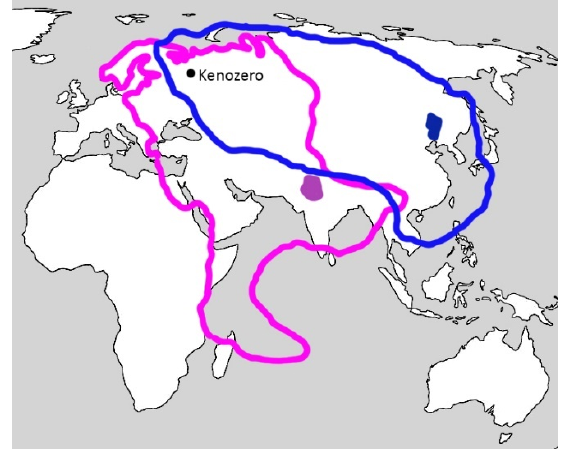
Figure 9. An example of two precipitation sheds which the Kenozero watershed belongs: light and dark purple colors show the boundary of the precipitation shed and the sink region in Pakistan and light and dark blue colors show the boundary of the precipitation shed and the sink region in China (after [71] with simplification).